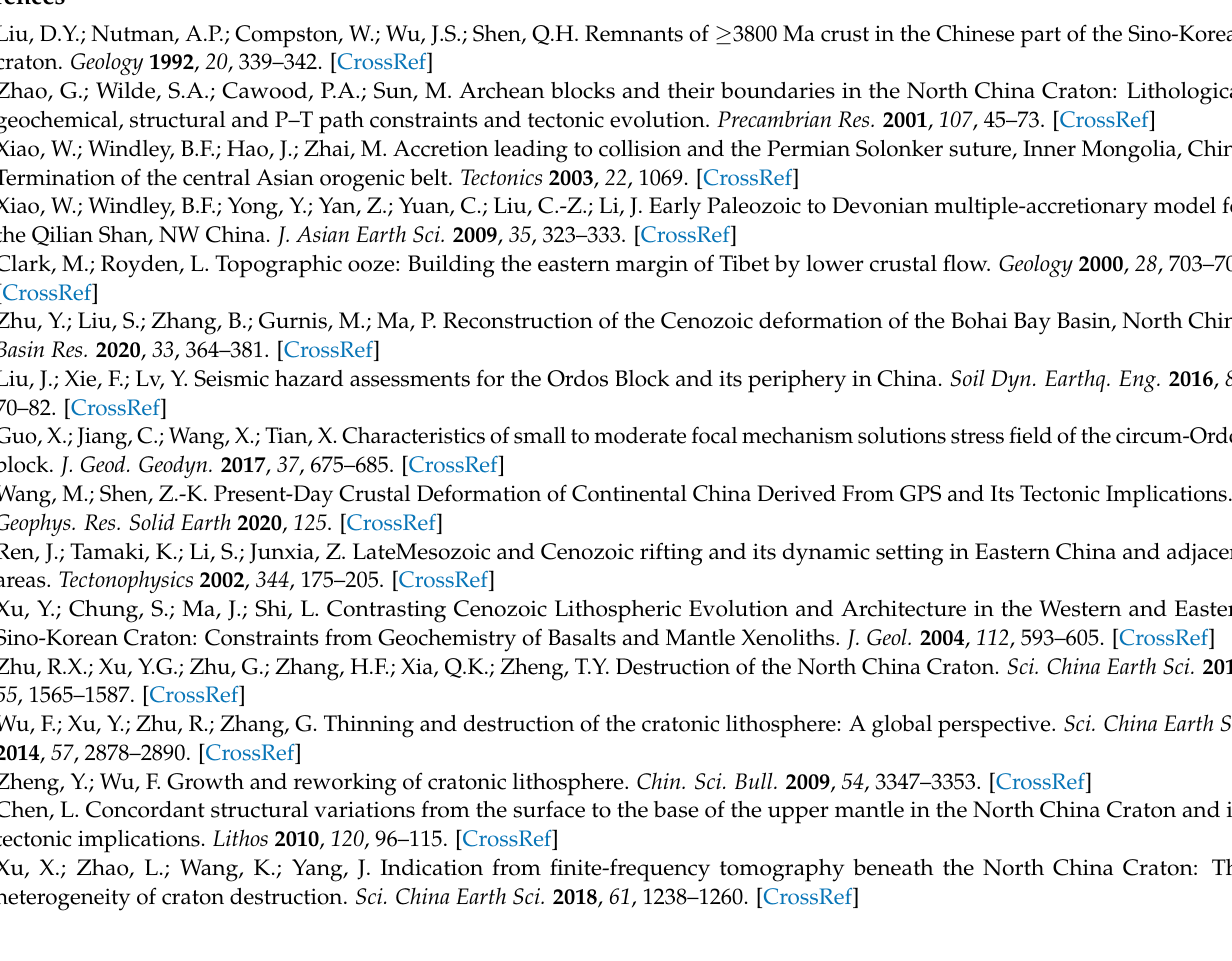
Figure 1. The black error bar denotes the magnitude and fast wave direction of azimuthal anisotropy. The average Rayleigh wave phase velocity (Ave.) at each period is shown in the corresponding panel. Figure S4: Refined Rayleigh wave phase velocity and azimuthal anisotropy at 30 period indicating the discontinuous low velocities in the northeastern margin of the Tibetan plateau. The abbreviations of geological blocks are defined in the caption of Figure 1. The black error bar denotes the magnitude and fast wave direction of azimuthal anisotropy. The average Rayleigh wave phase velocity (Ave.) at 30 s period is shown in the